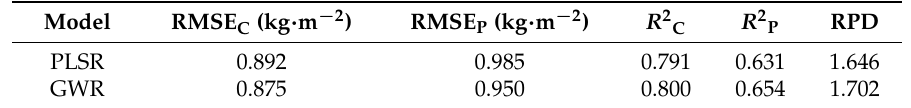
Figure 5. The scatter plot of the measured and predicted soil organic carbon density (SOCD) values of the validation dataset by principal least squares regression (PLSR) and geographically-weighted regression (GWR) models. Table 4. The basic statistics of different evaluation indices by principal least squares regression (PLSR) and geographically-weighted regression (GWR) models.